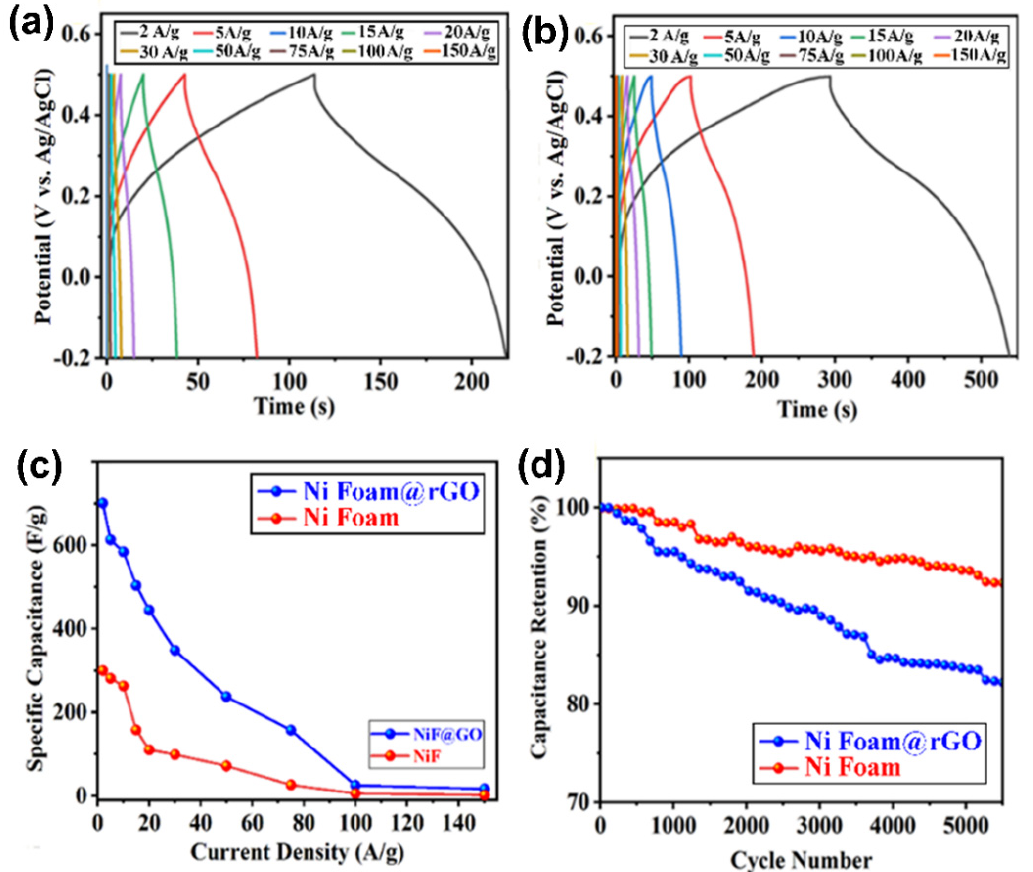
Figure 12. GCD curves of a typical Co x NiV y O z material deposited on various substrates. ( a ) Ni foam substrate, ( b ) Ni foam@rGO substrate at current density ranging from 2 to 150 A/g in KOH electrolyte (1.0 M). ( c ) Calculated specific capacitance, and ( d ) capacitance retention of Co x NiV y O z electrodes deposited on various substrates.